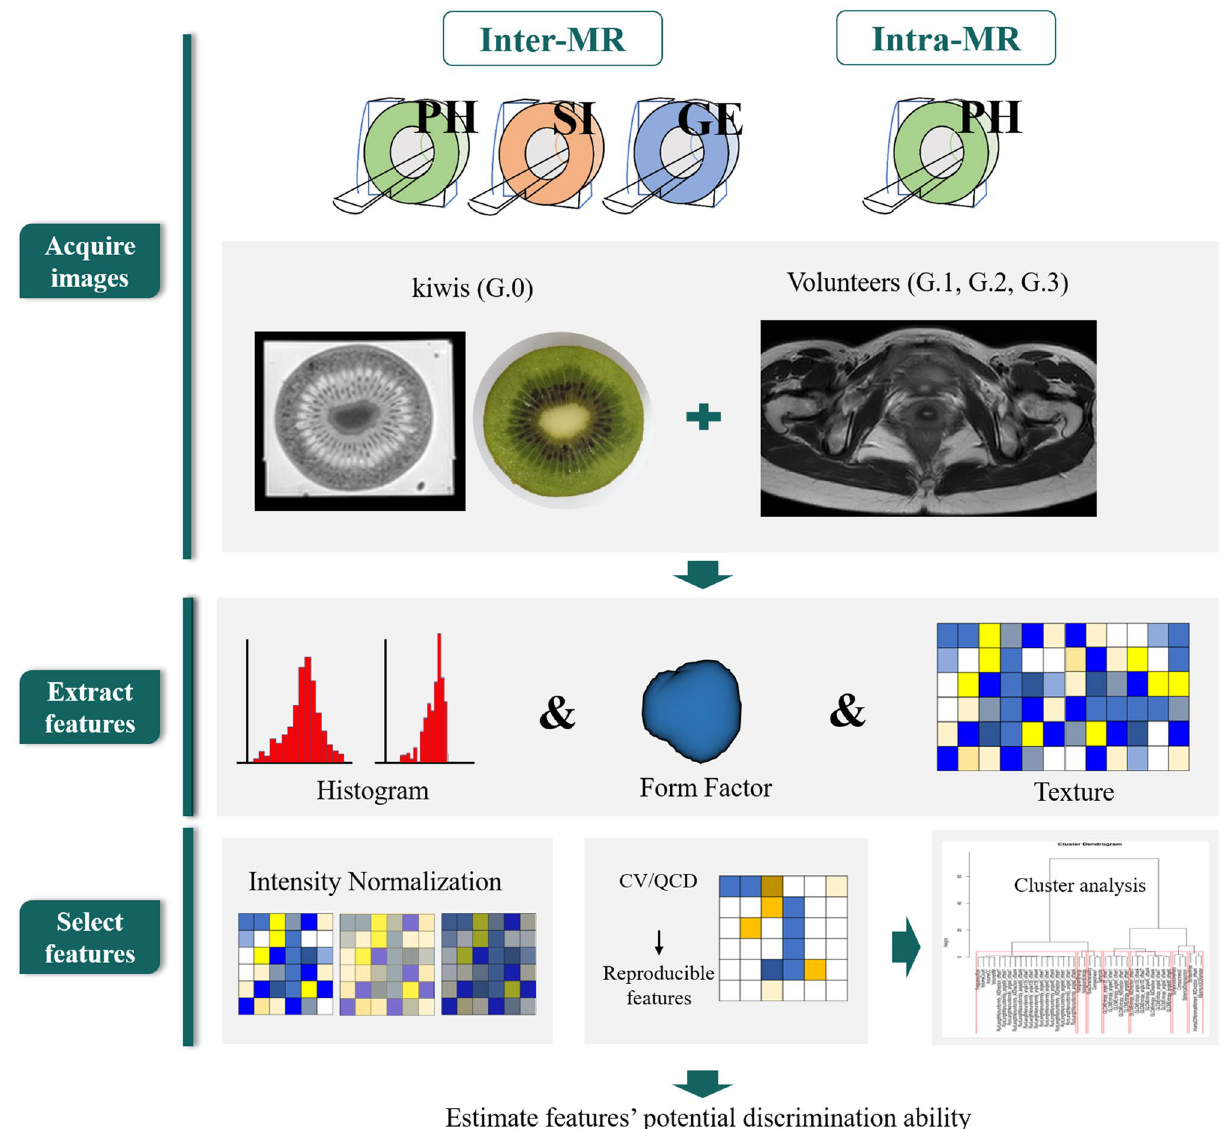
Figure 4. Study workflow. Note “Form Factor” means geometric feature; PH Philips Medical Systems; GE GE Medical Systems; SI Siemens Medical Systems; G.0–G.3 group 0–group 3. CV the coefficient of variation, QCD the quartile coefficient of